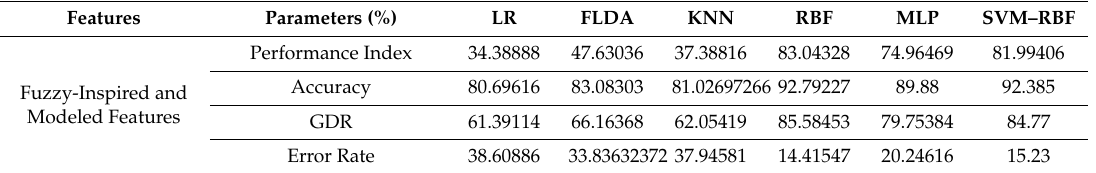
Table 14. Average performance of parameters among the classifiers at various optimization techniques with di ff erent features for normal cases.